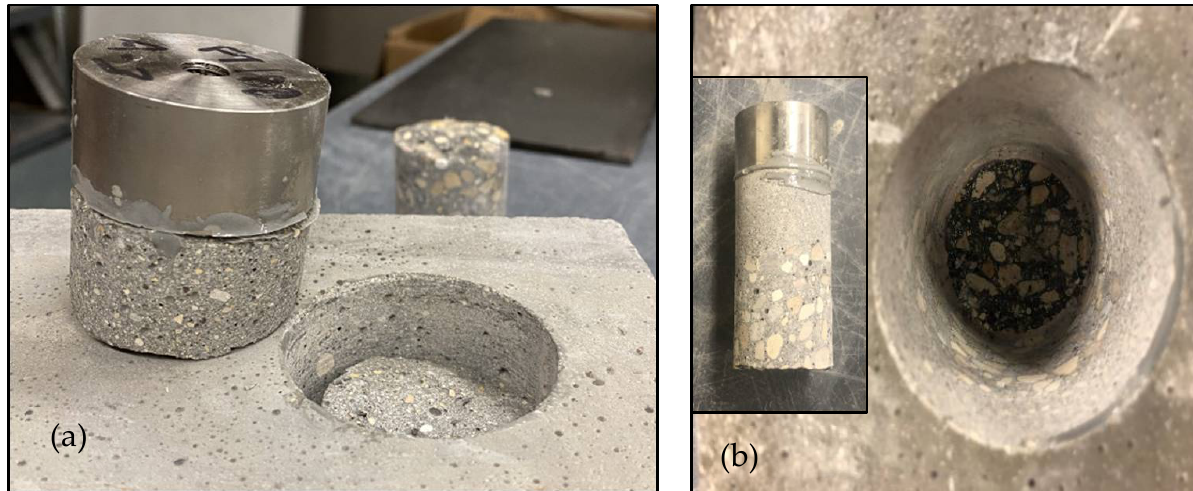
Figure 9. Exemplar mode of failure from the pull-off test for a ) H-X-0.0; b ) H-B-2.5.